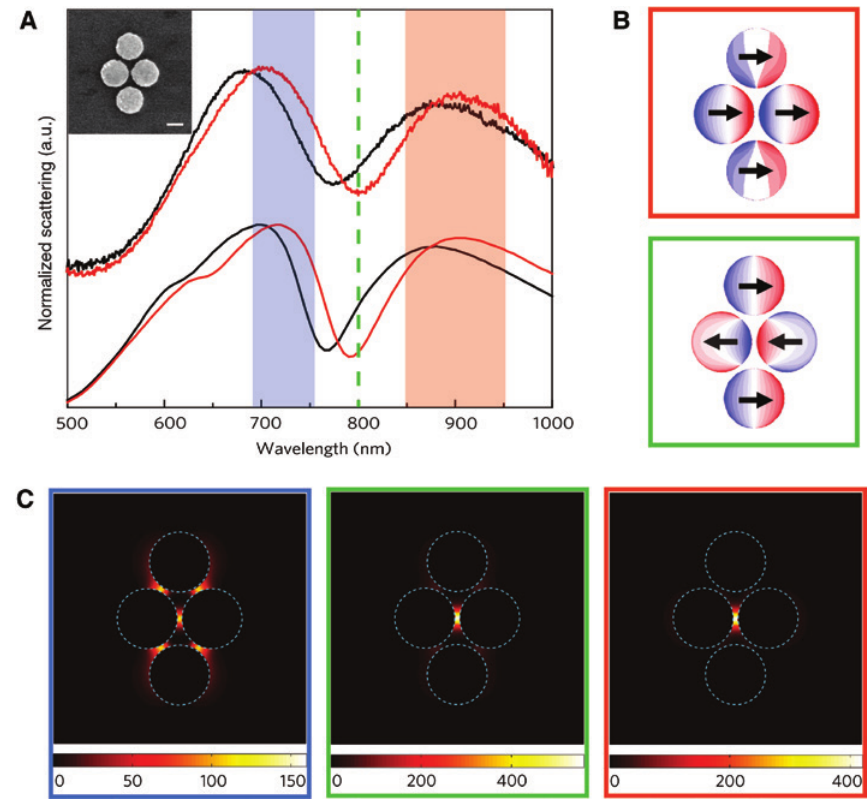
Figure 13: The gold quadrumer antenna with optimized properties for the SE-CARS. (A) The experimental (top) and calculated (bottom) scattering spectra of the quadrumer antenna determined before (black) and after (red) molecule adsorption. Green dashed line: the pump beam (800 nm); red zone: the Stokes scattering region (848–952 nm); blue zone: the anti-Stokes scattering region (756–690 nm). (B) The charge densities on the top surface of the quadrumer excited at 800 nm pump (top) and 900 nm Stokes (bottom), corresponding to the subradiant and superradiant modes, respectively. (C) The field enhancement intensity distribution at the anti-Stokes (left), pump (middle) and Stokes (right) frequencies at mid-height of the quadrumer. Adapted with permission from Ref.